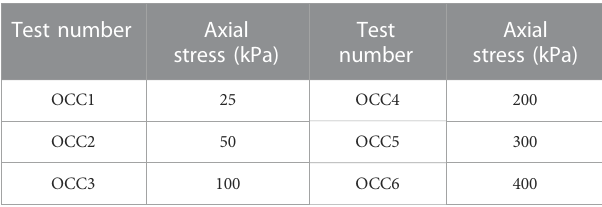
TABLE 2 One dimensional consolidation creep test